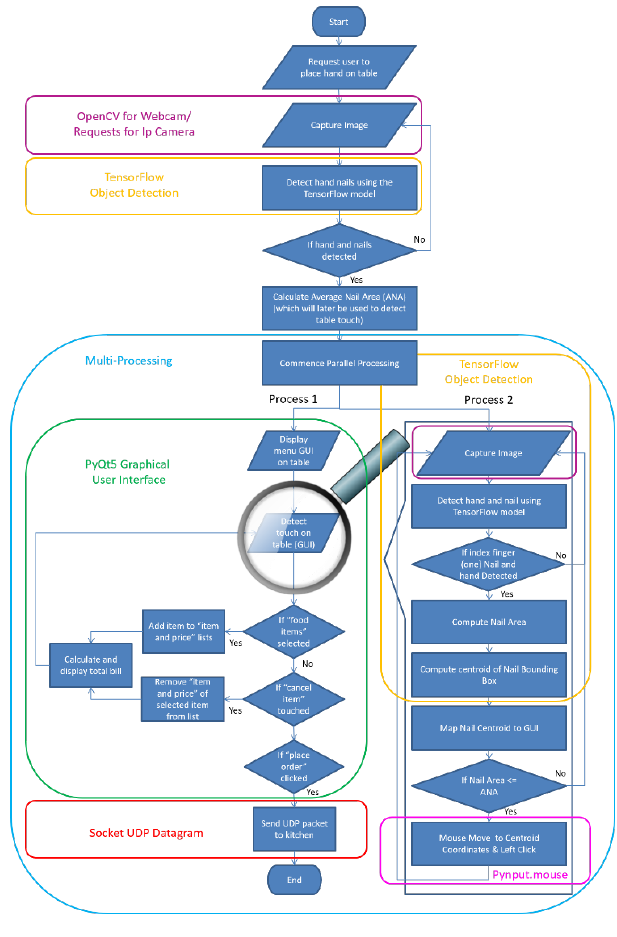
Fig. 12. System flow